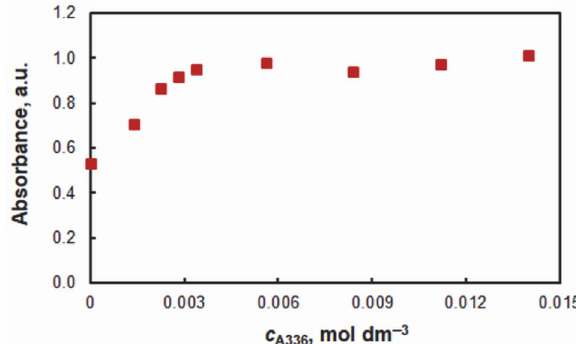
Figure 4. Absorbance vs. concentration of A336. c Ni = 2 × 10 −5 mol dm −3 , c MTAR = 2.0 × 10 −4 mol dm −3 , pH 8.5, V aq. phase = 10 cm 3 , ex- traction time t = 60 sec.